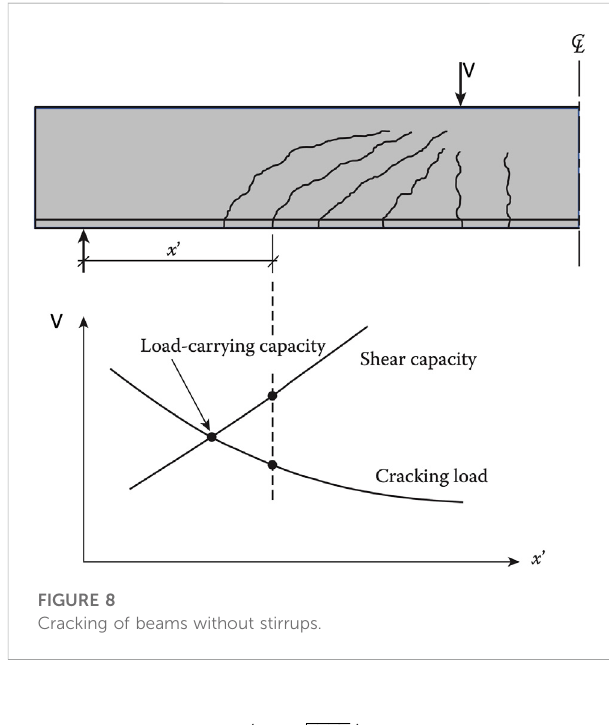
FIGURE 8 Cracking of beams without